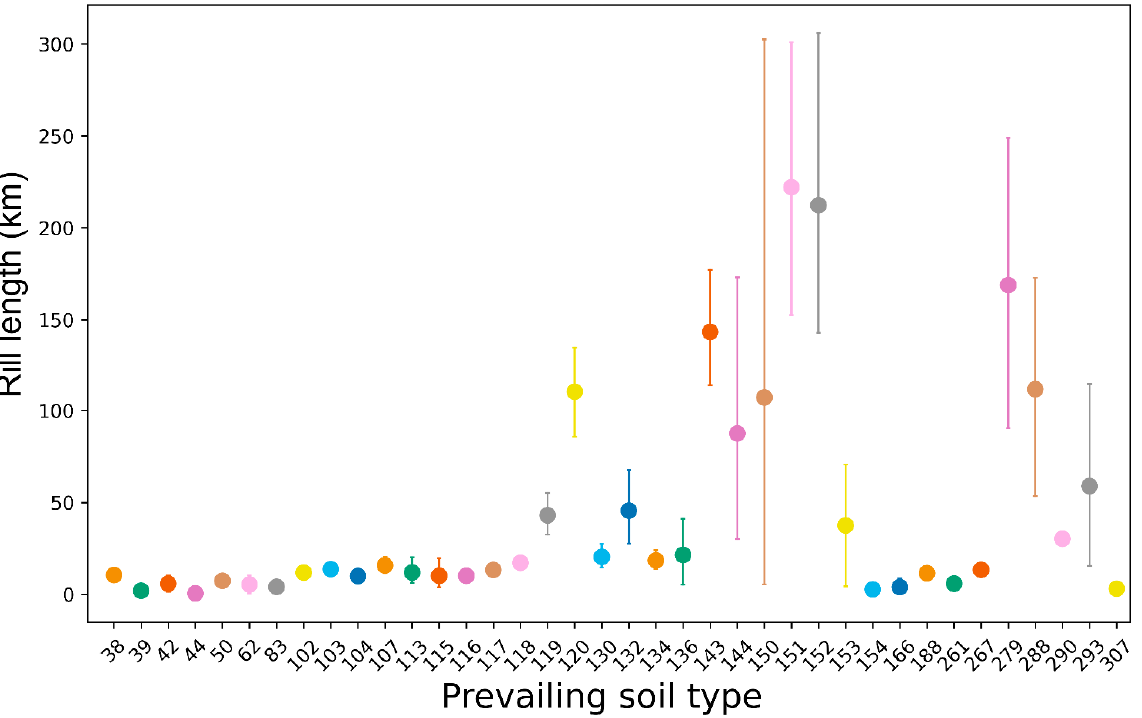
Figure 17. Dependence of the length of the erosion network on the prevailing soil type. Soil types are given in the Supplementary Materials.